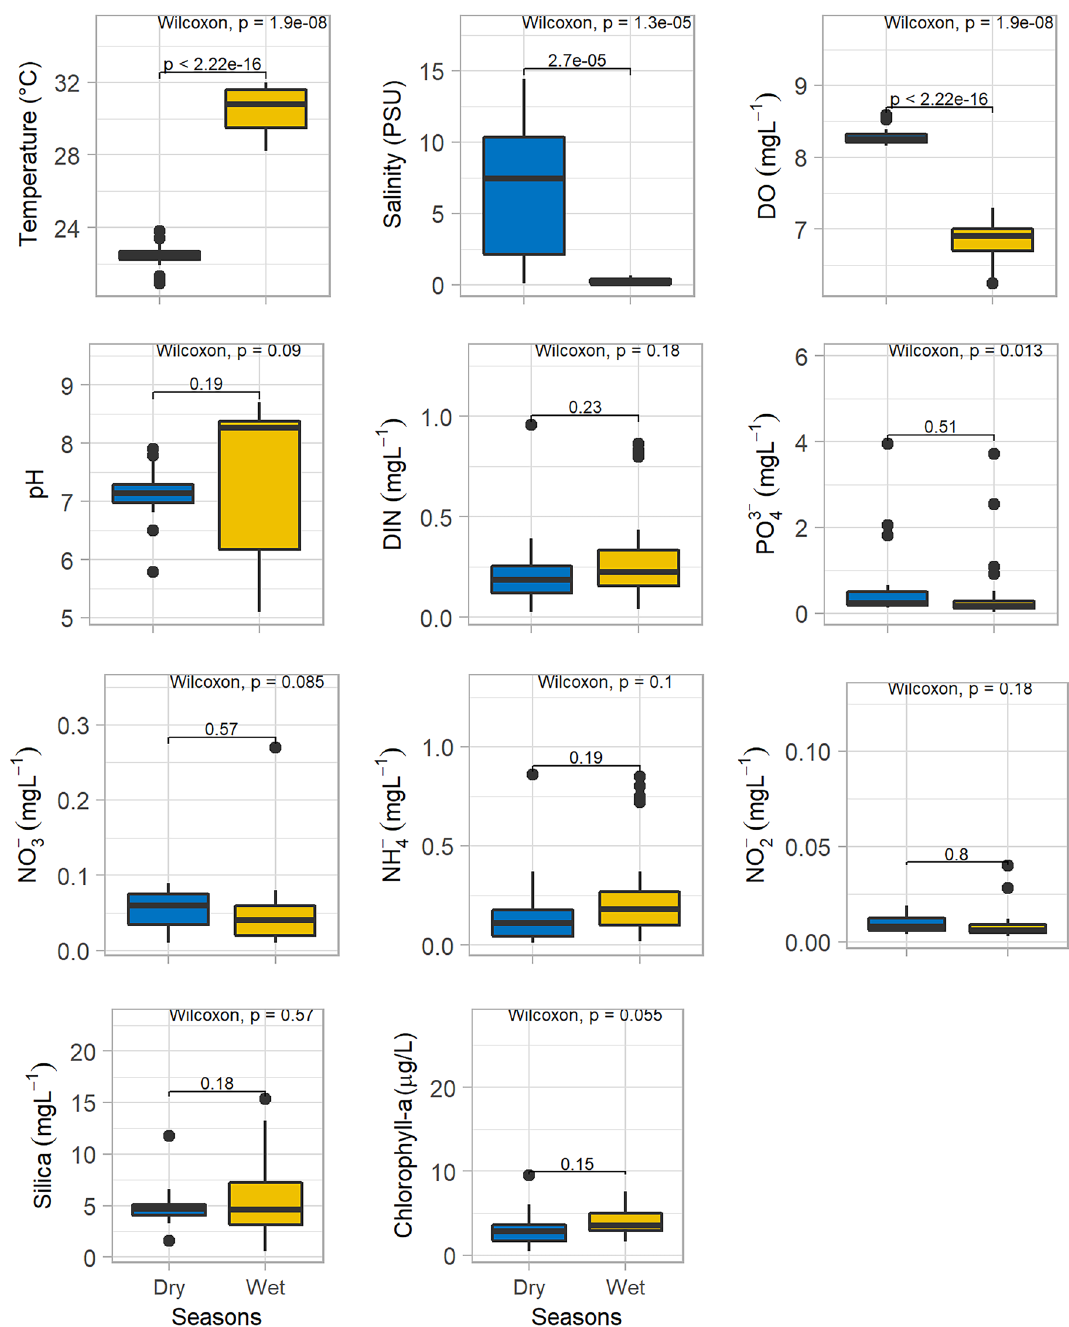
Figure 4. Temporal variations of major hydro-chemical parameter, dissolved inorganic nutrients and chlorophyll-a in the lower Meghna River estuary (UE = Upper estuary, ME = Middle estuary, LE = lower estuary, CK = Char Kukrimukri, HI = Hatiya Island). Note: the top, middle and bottom lines of the Box plot denote the upper quartiles, median and lower quartiles, respectively. The vertical line extending upward and downward denotes the range of data distribution. A data point located outside the whiskers of the box plot is called an